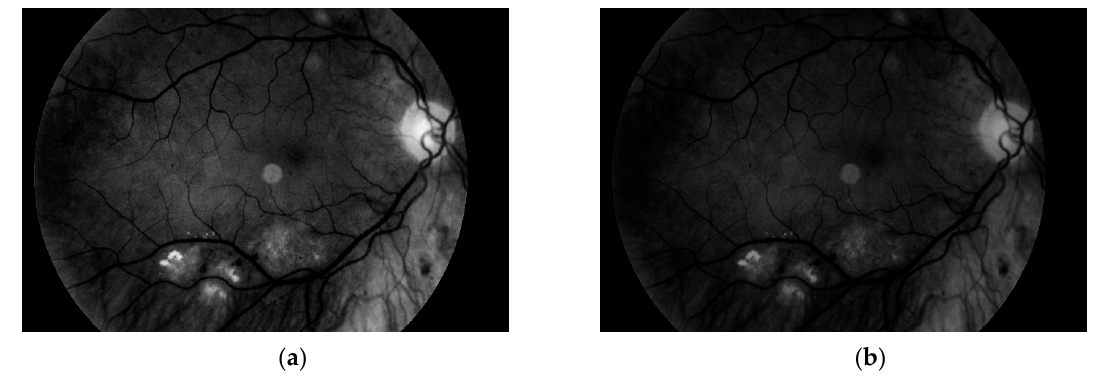
Figure 7. Image after ( a ) histogram stretching and ( b ) median filtering.